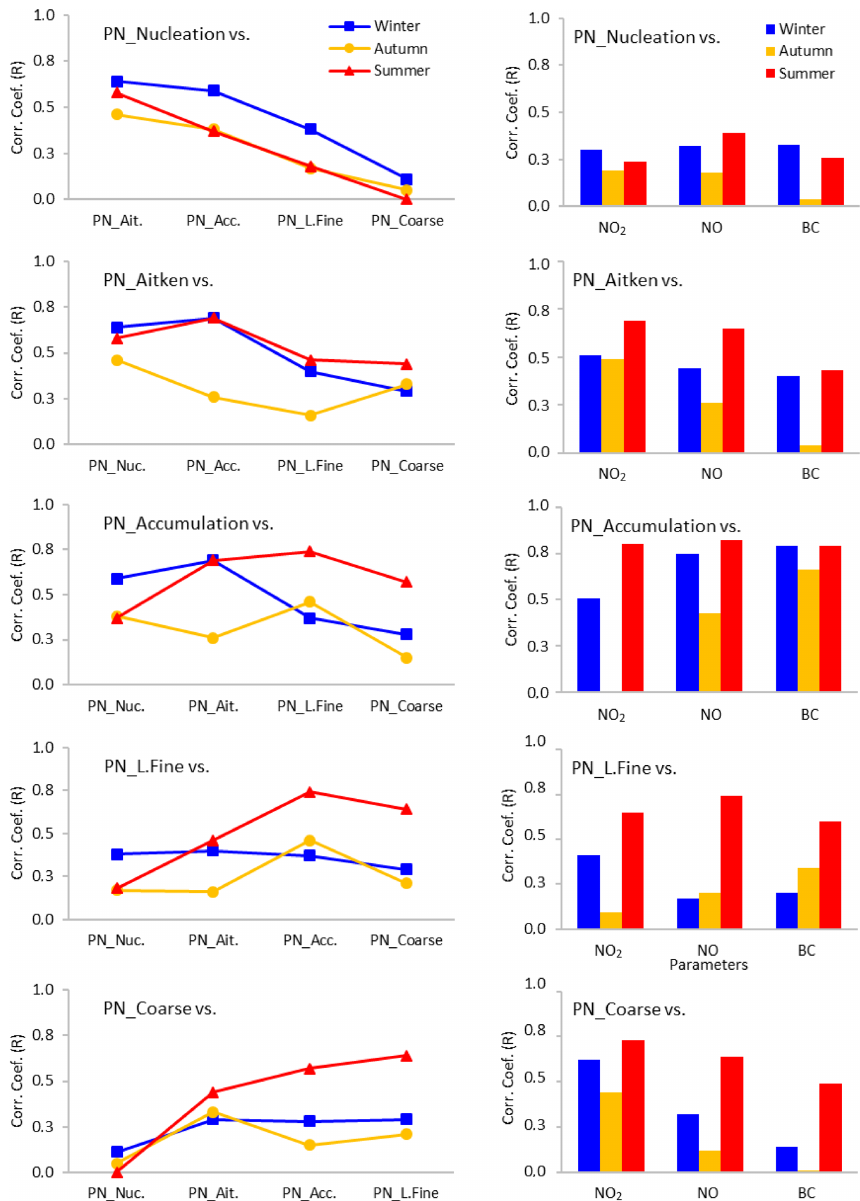
Figure 10. Correlation coefficient ( R ) between the hourly average PNs of five particle size fractions (left side) and NO, NO 2 , and BC (right